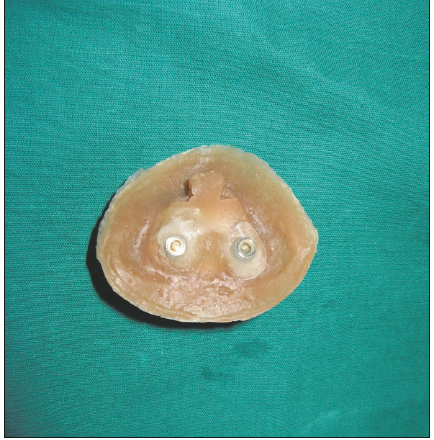
Figure 6: Definitive nasal prosthesis with metal encapsulator of O- ring attachment incorporated in resin